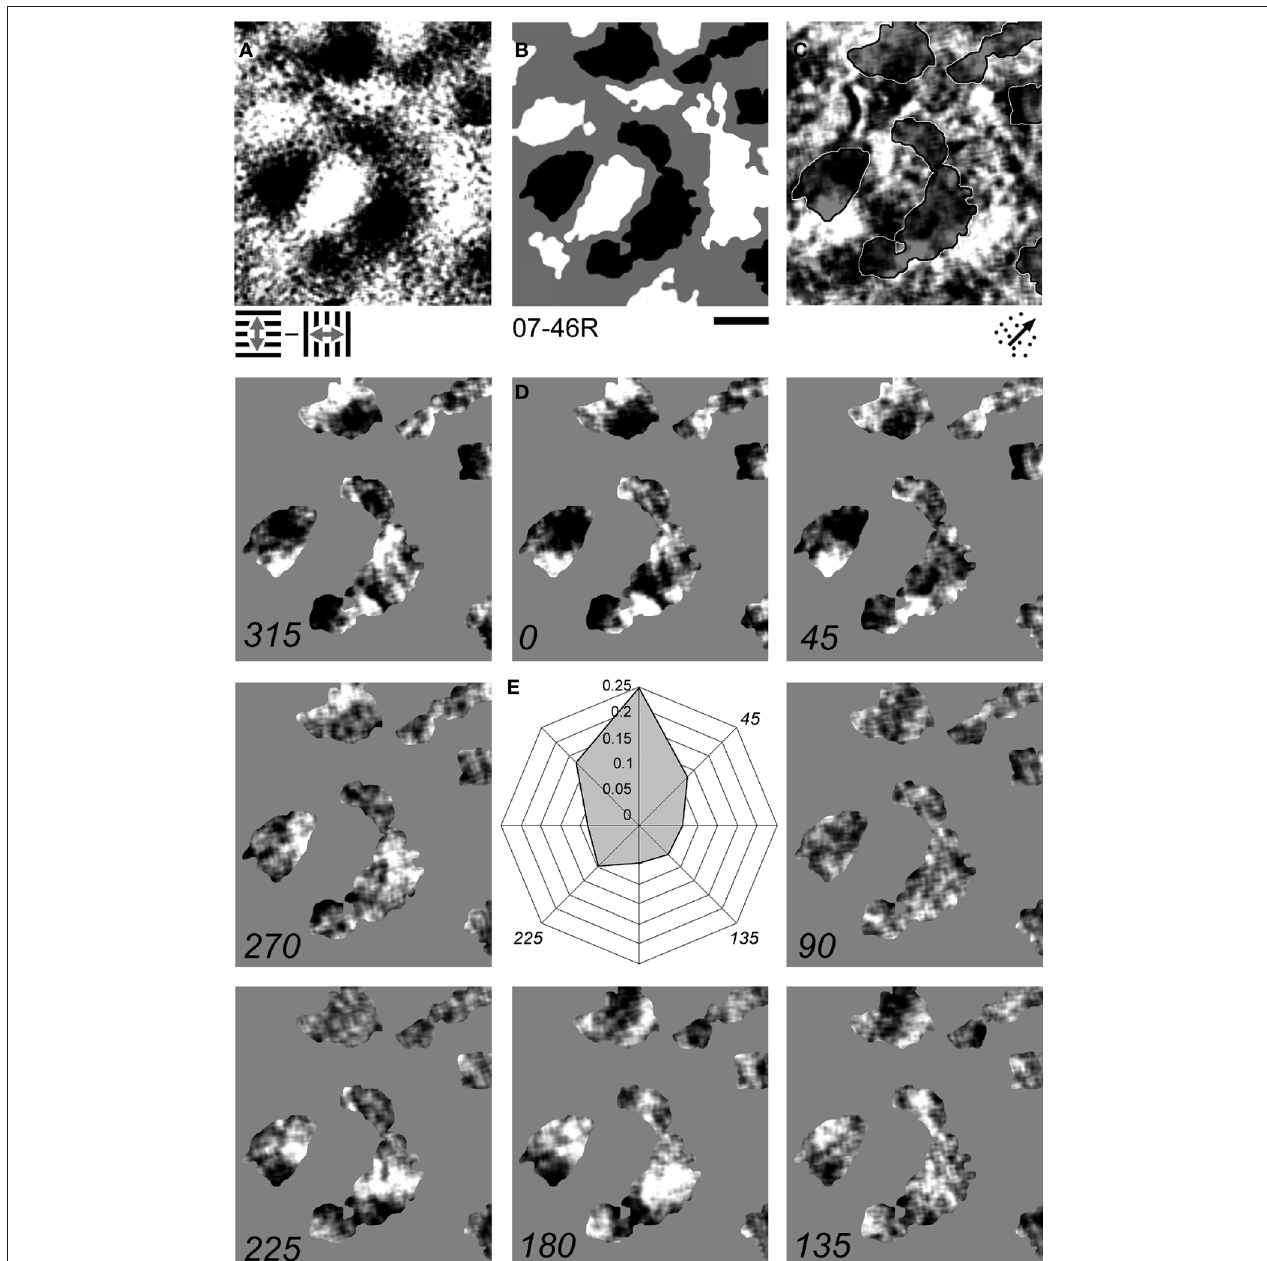
Figure 5 | Methodology to reveal the relationship between axis-of-motion and direction-of-motion domains. The procedure illustrated here produces a radial plot showing the direction-of-motion response for all horizontal (H) domains within the ROI (see Materials and Methods). In (A) , a HV map is shown. In (B) , the same map has been thresholded (see Materials and Methods). The horizontal domains defined through thresholding have been